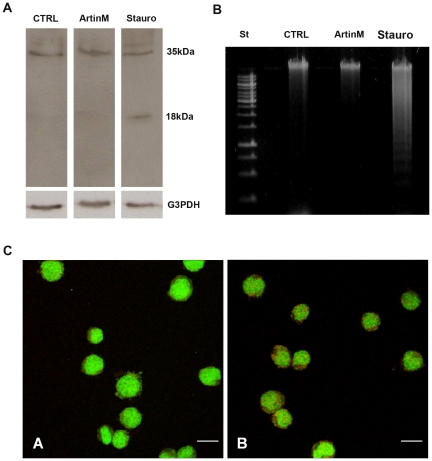
Autophagy accounts for the caspase-independent mechanism of NB4 cell death induced by ArtinM.NB4 cells were cultured with ArtinM (10 µg/mL) for 48 h or with Staurosporine (Stauro, 5 µM) for 4 h. A) Caspase-3 activation, manifested by cleavage of their precursor forms, was analyzed by Western blotting of RIPA cell lysates (100 µg protein) performed under reducing conditions. B) Fragmentation of genomic DNA from NB4 cells was evaluated by electrophoresis on 1% agarose gel followed by ethidium bromide visualization. St: standard markers. C) Acidic autophagic vacuoles in NB4 cells were detected through staining with 10 µg/mL acridine orange in serum-free medium. Fluorescent micrographs show that the cytoplasm and nucleus of stained cells fluoresced bright green, whereas the acidic autophagic vacuoles fluoresced bright red. Bar = 10 µm.